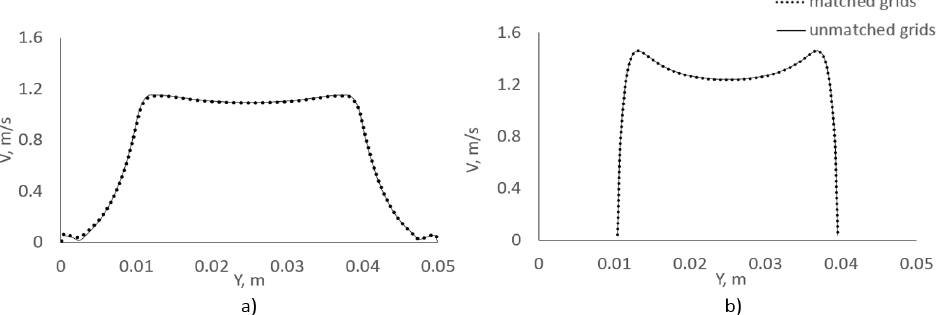
Figure 12. Profile of velocity at the control sections: ( a ) section A1, ( b ) section A2.